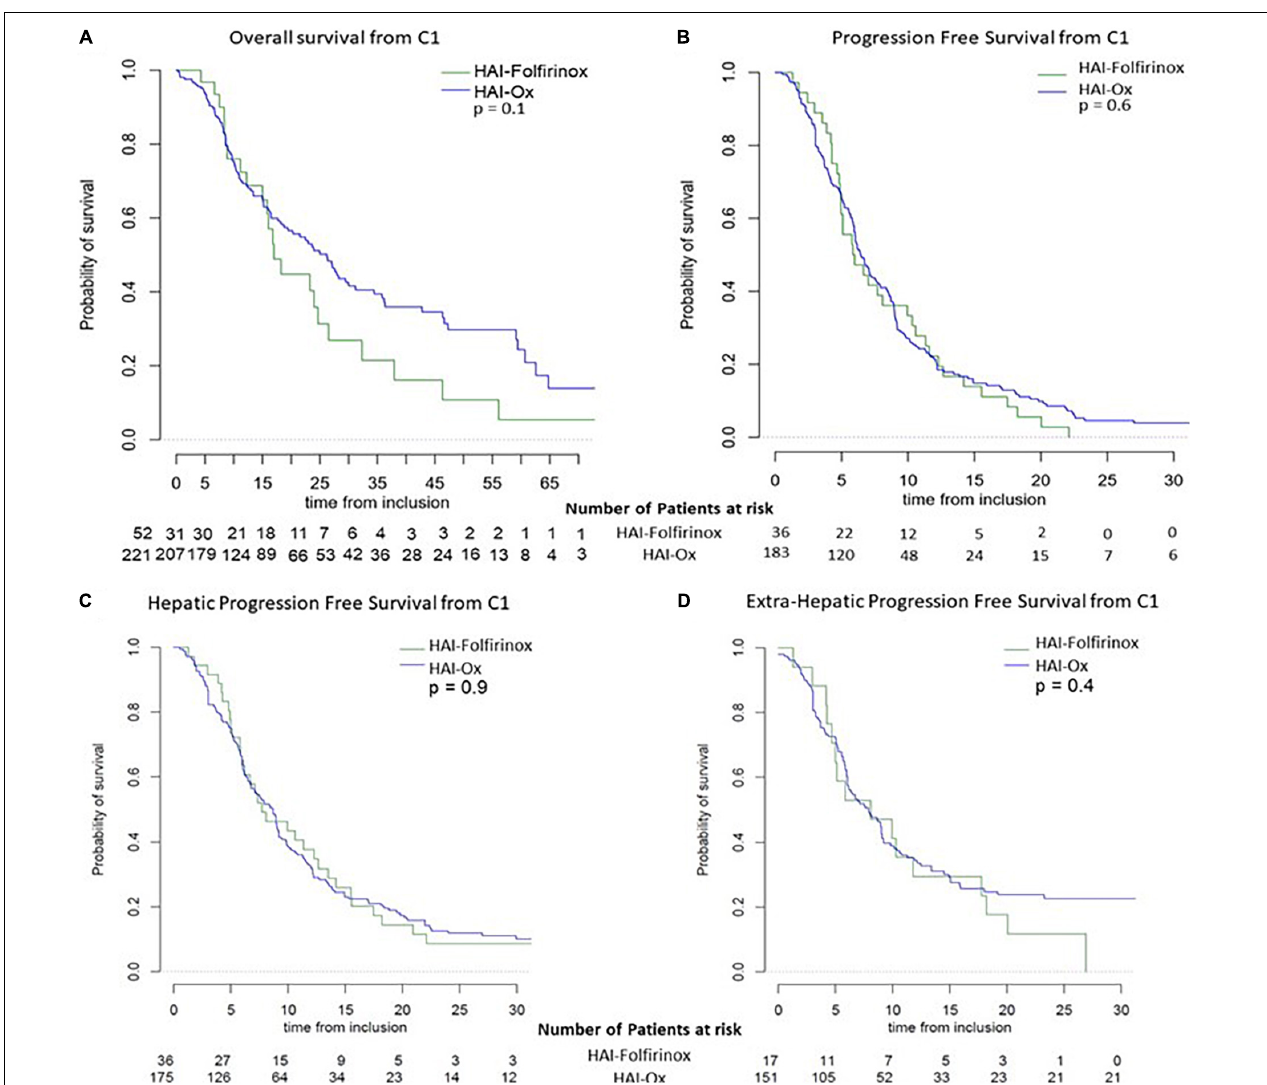
FIGURE 1 | Survival curves depend on HAI treatment. Overall survival (A) and progression-free survival (B) in patients with HAI-Folfirinox and HAI-Ox. Specific hepatic progression-free survival (C) and extra-hepatic progression-free survival (D) in patients with HAI-Folfirinox and HAI-Ox.